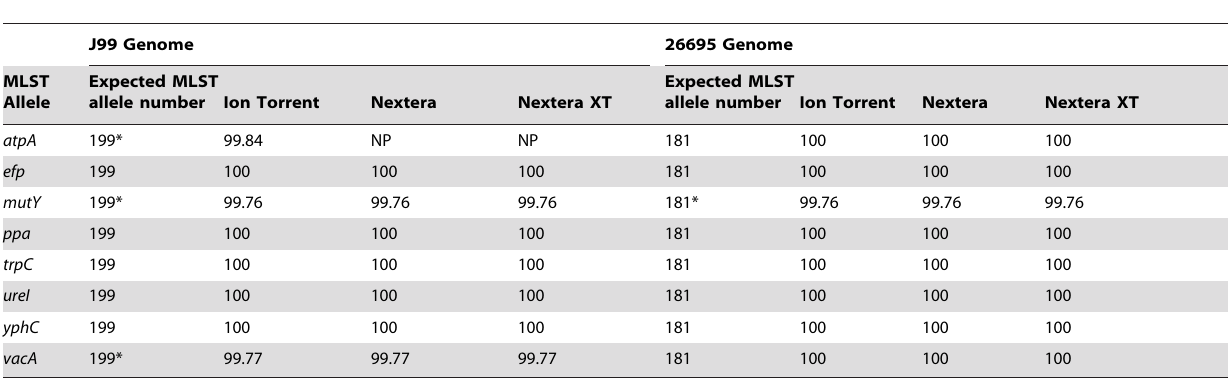
Table 5. Percentage sequence identity of MLST alleles extracted from assembled data.